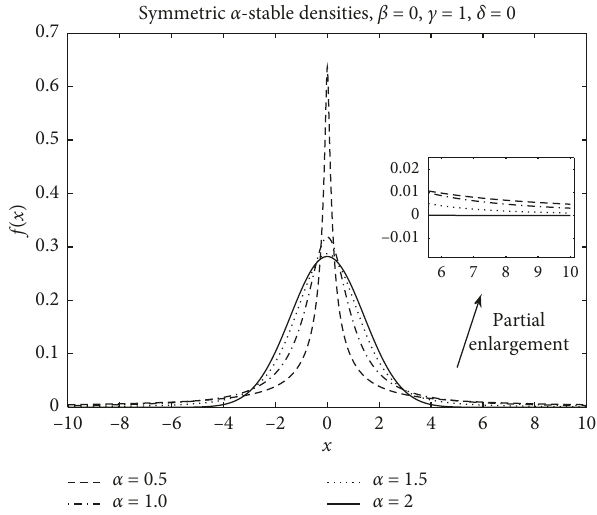
Figure 1: Different PDF curves with different α